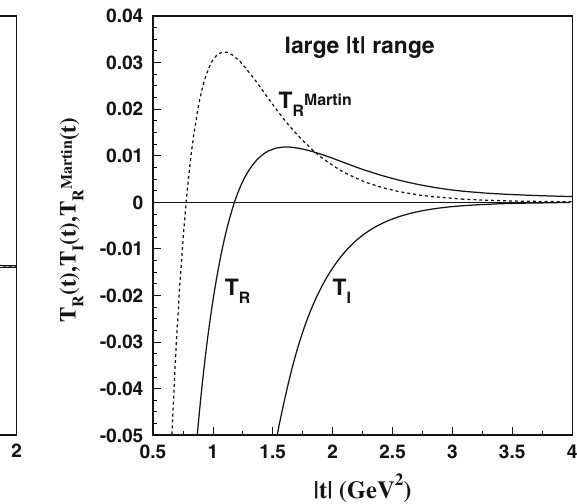
KFK calculation compared with the prediction T Martin ( t ) using tin’s Formula using same T I ( | t | ) ; the real amplitudes are positive in R both cases, with magnitudes dominant (slightly in the case of Martin’s Formula) over the negative imaginary